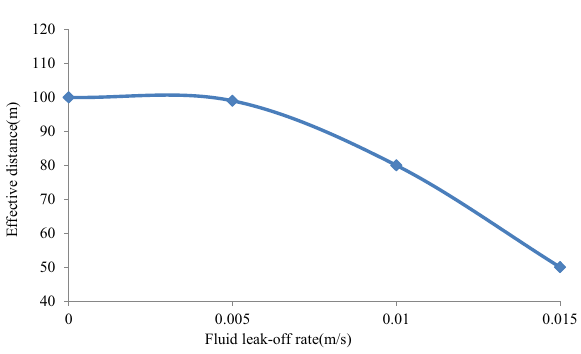
Fig. 7 Filling ratios at different fluid leak-off